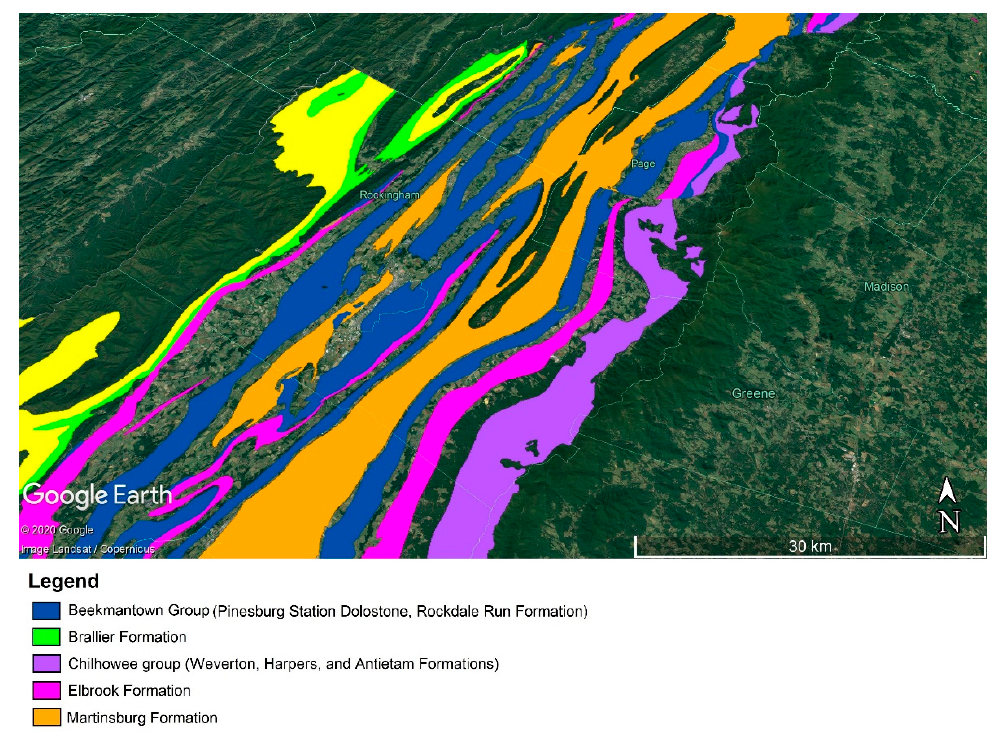
Figure 3. Simplified geologic map designed to localize the geologic units where the samples analyzed belong. The map was based on the U.S. Geological Survey (USGS) GIS database of geologic units, lithology, age, and structural features in Virginia [20].